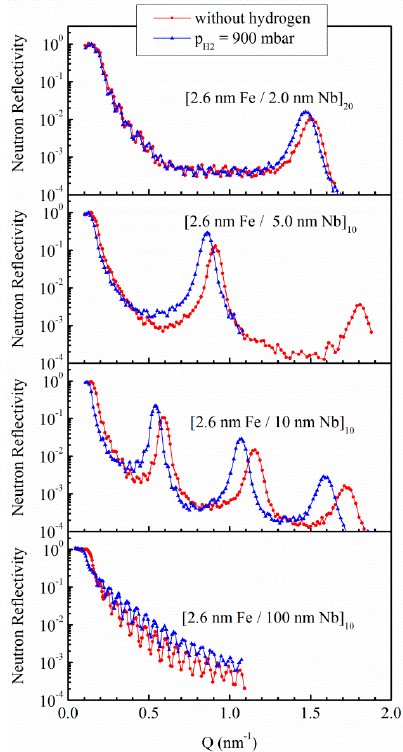
Figure 6. Unpolarized neutron reflectivity data for several polycrystalline Fe/Nb heterostructures. The red curves represent data taken in the virgin (pre ‐ hydrogen) state, while the blue curves represent data taken at the highest hydrogen pressure of 900 mbar.